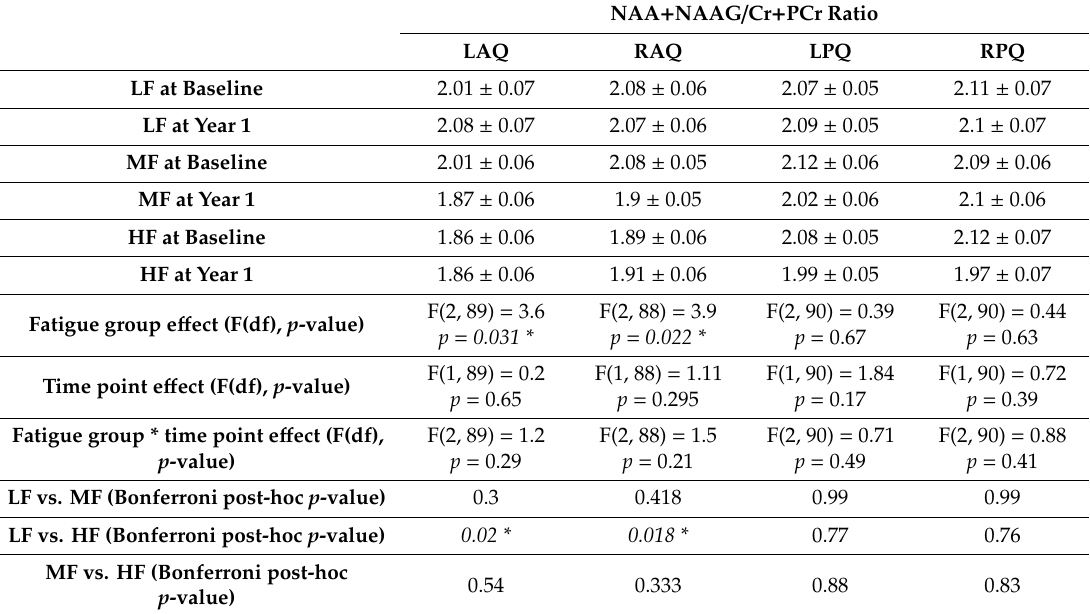
Table 2. Two-way ANOVA with pairwise comparisons of the NAA + NAAG / Cr + PCr ratio between the fatigue